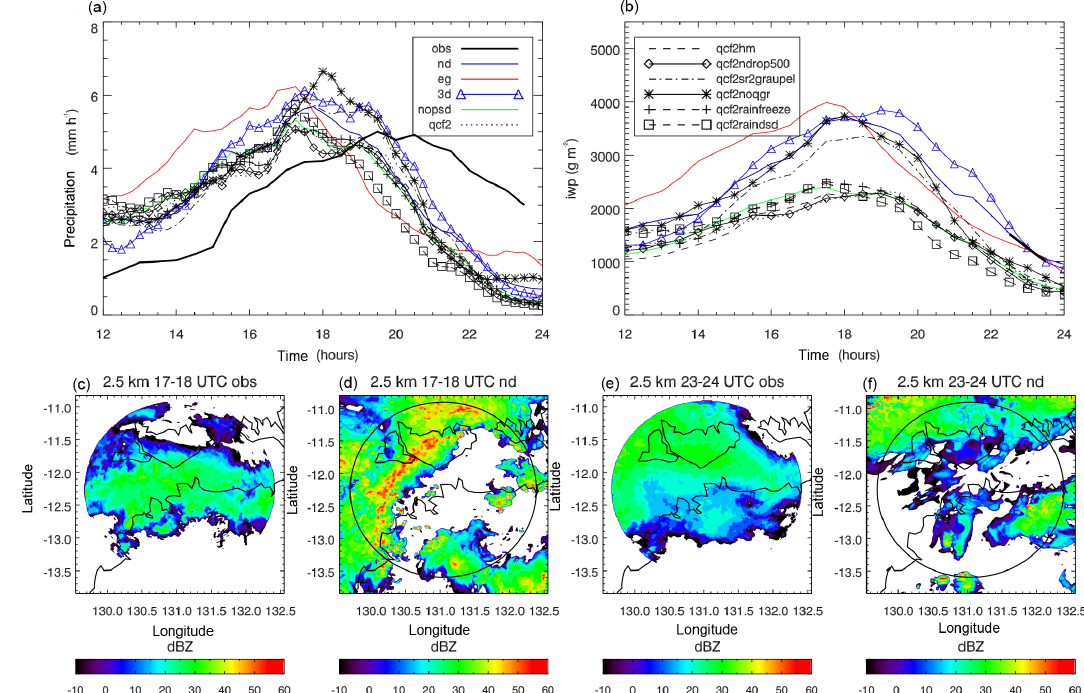
Figure 3. Time series of domain mean: (a) precipitation (mmh − 1 ) and (b) ice water path (gm − 3 ) . The observations are from the CPOL radar in (a) and the satellite retrieval in (b) ; note that the observed IWP is only plotted from 22:30 to 23:30. The time period spans 12:00– 24:00UTC on 18 February 2014. (c) 2.5km observed radar reflectivity averaged over 17:00–18:00UTC. (d) As in (c) except for the modelled reflectivity from the control simulation (nd), (e) as in (c) except for 23:00–24:00UTC, (f) as in (d) except for